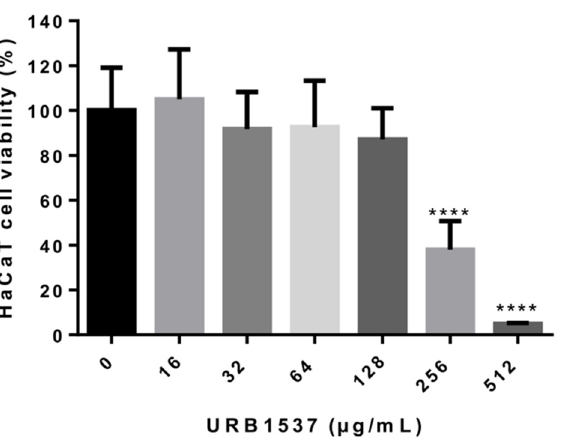
Figure 2. Cell viability evaluation after URB1537 administration to HaCaT cells for 24 h. Data are expressed as the mean ± SD ( n = 3). **** p < 0.0001 vs. untreated control cells (Tukey’s post hoc test).